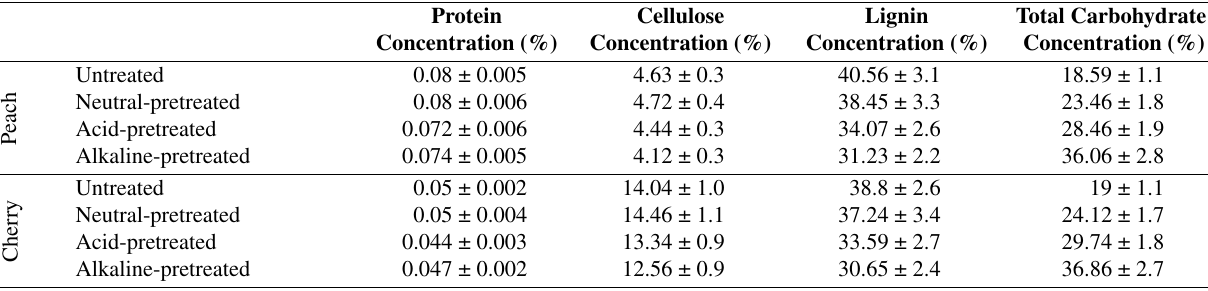
Table 1. The changes of main components of peach and cherry wastes after all